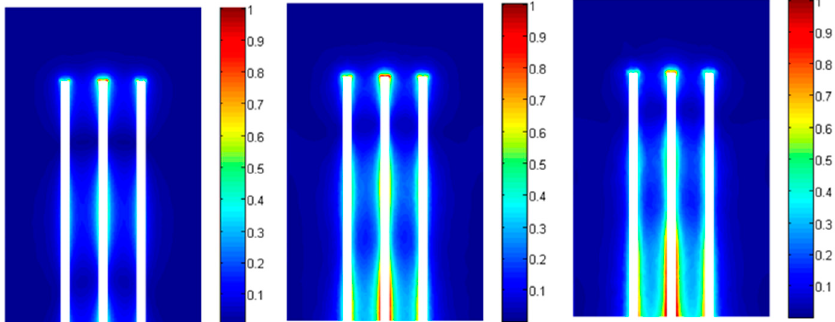
Figure 6. Electric field distribution @1 GHz in the YOZ plane (from left to right: θ = 0.022 m 3 /m 3 , θ = 0.066 m 3 /m 3 and θ = 0.157 m 3 /m 3 ). Sensors 2016 , 16 , 554